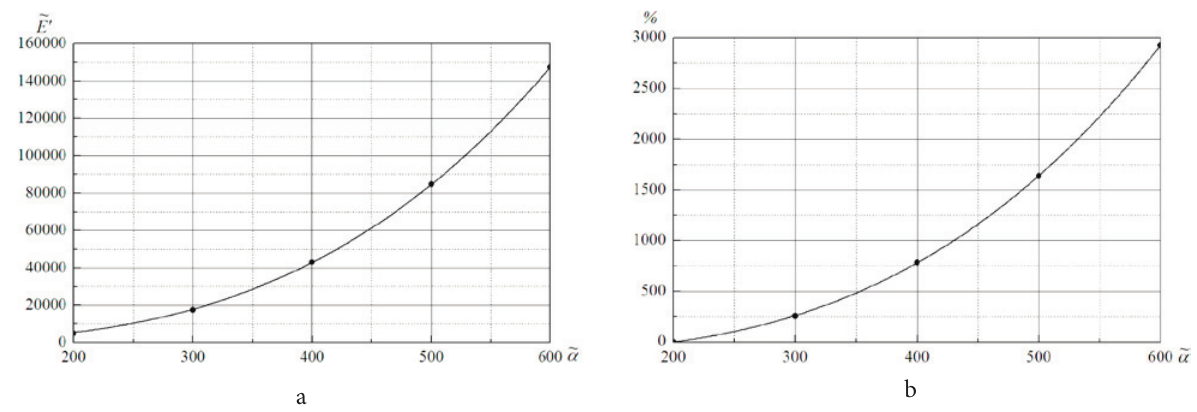
Fig. 4. Diagrams of the variation in the rate of accumulated energy E'  ( a ) and the percentage of increase in the rate of accumulated energy ( b ) of a resulting acoustic emission signal depending on the value α  when α  is equal to 200